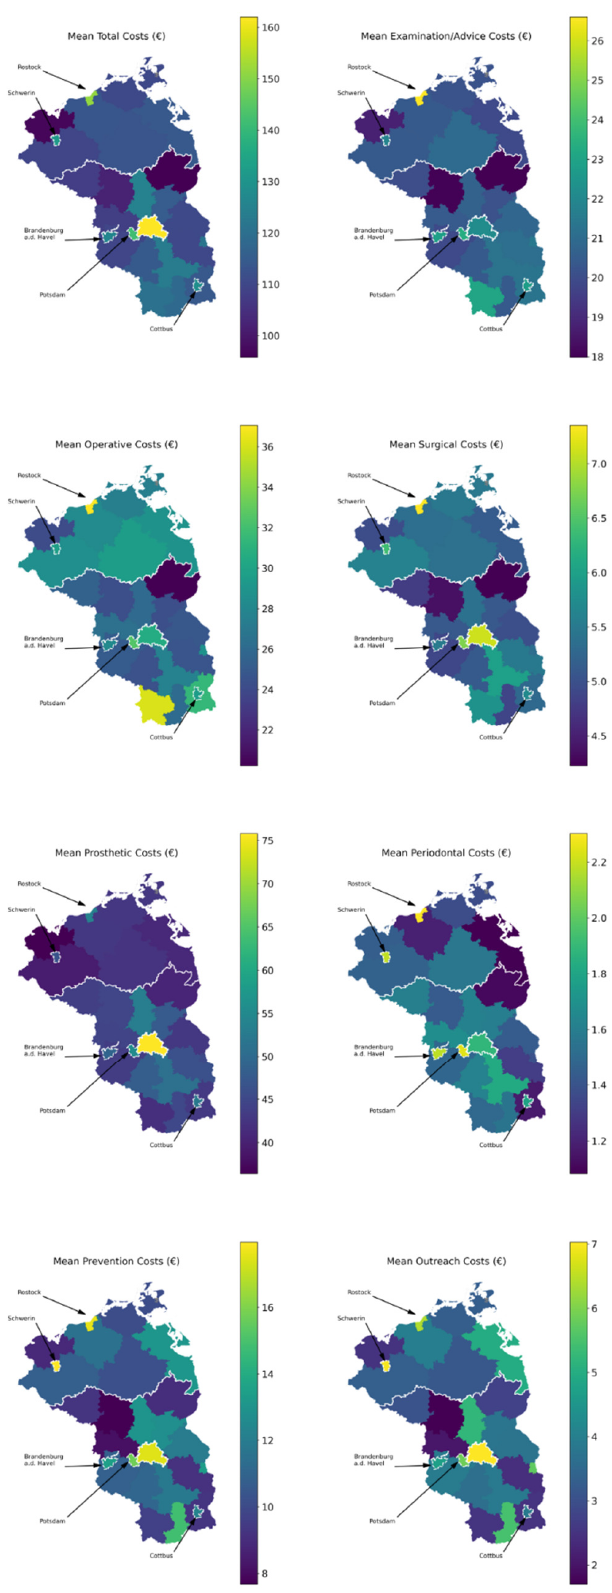
Figure 2. Regionally specific mean costs across the years (in euro 2012) of dental services provided to the very old in Northeast Germany. Total costs as well as costs for examination/advice, operative, surgical, prosthetic, periodontal, preventive and outreach services are shown. Larger cities are highlighted by arrows.